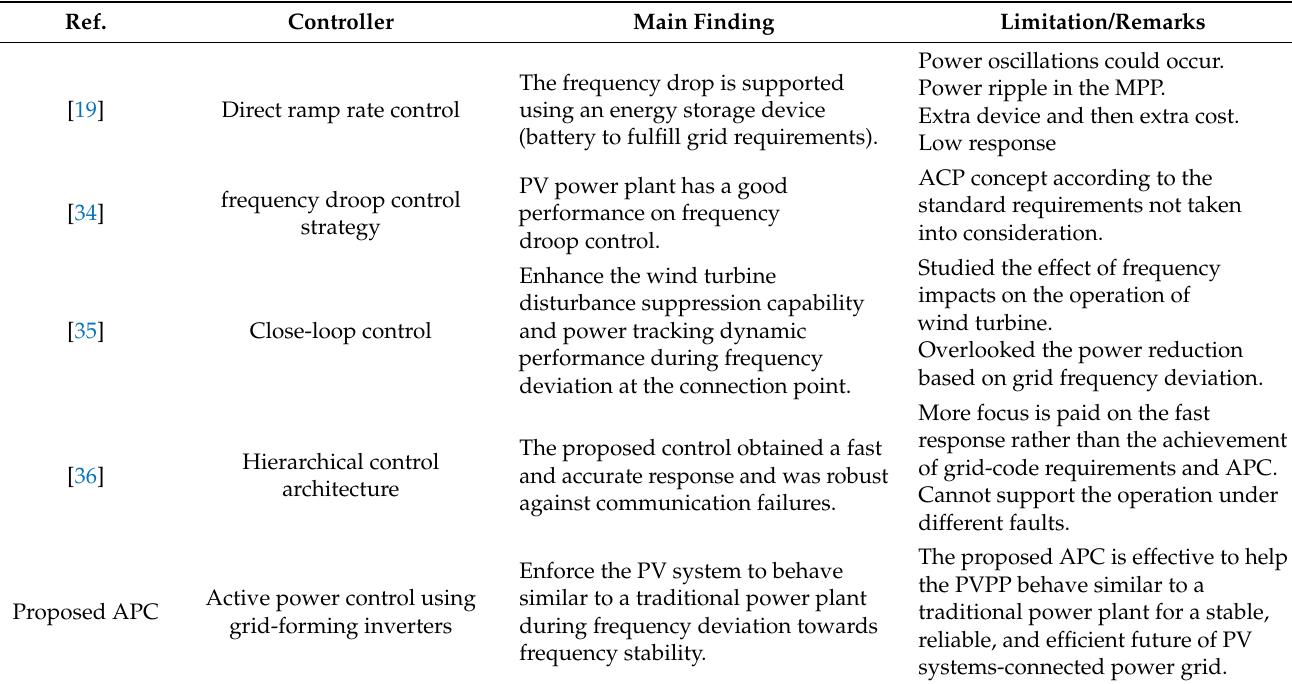
Table 3. Comparison between the proposed and existing